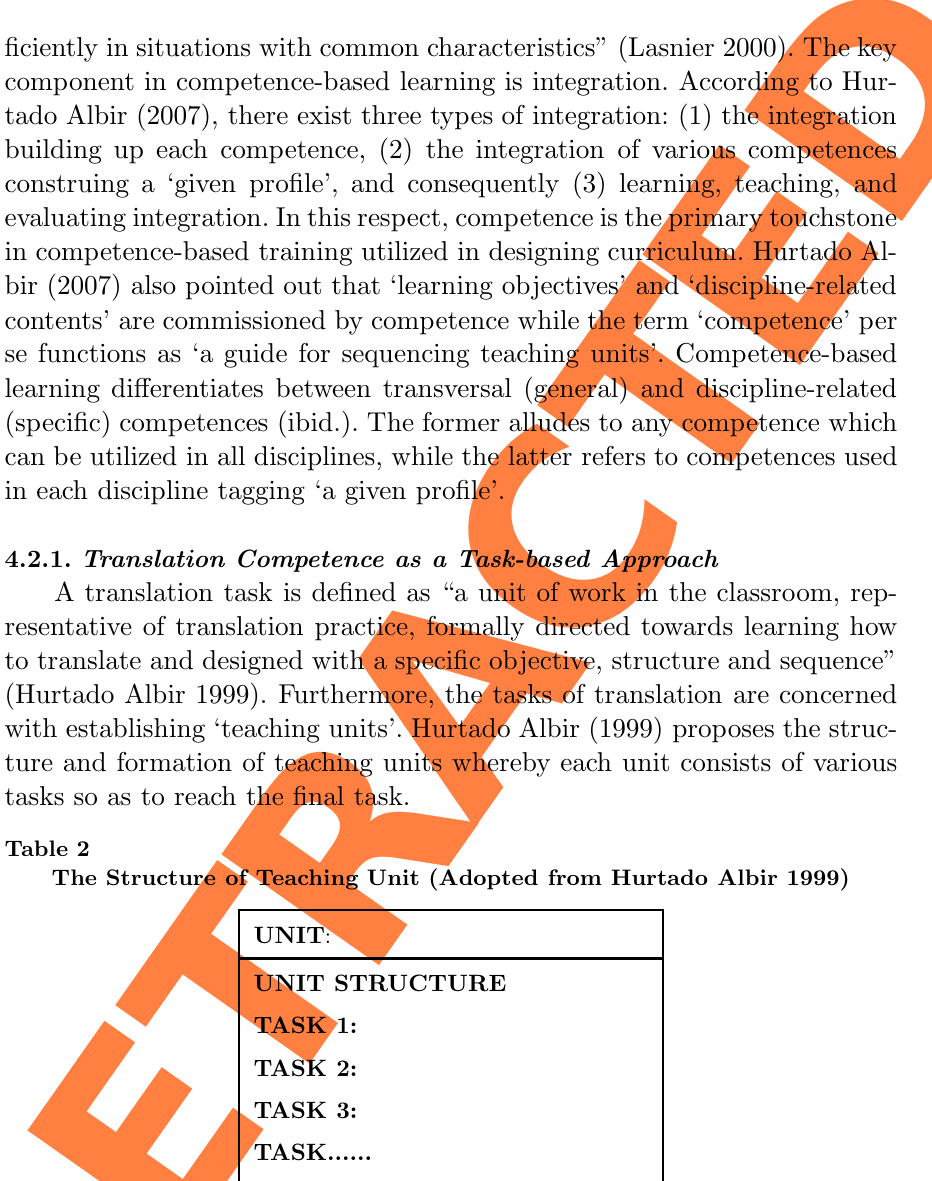
The Structure of Teaching Unit (Adopted from Hurtado Albir 1999) UNIT : UNIT